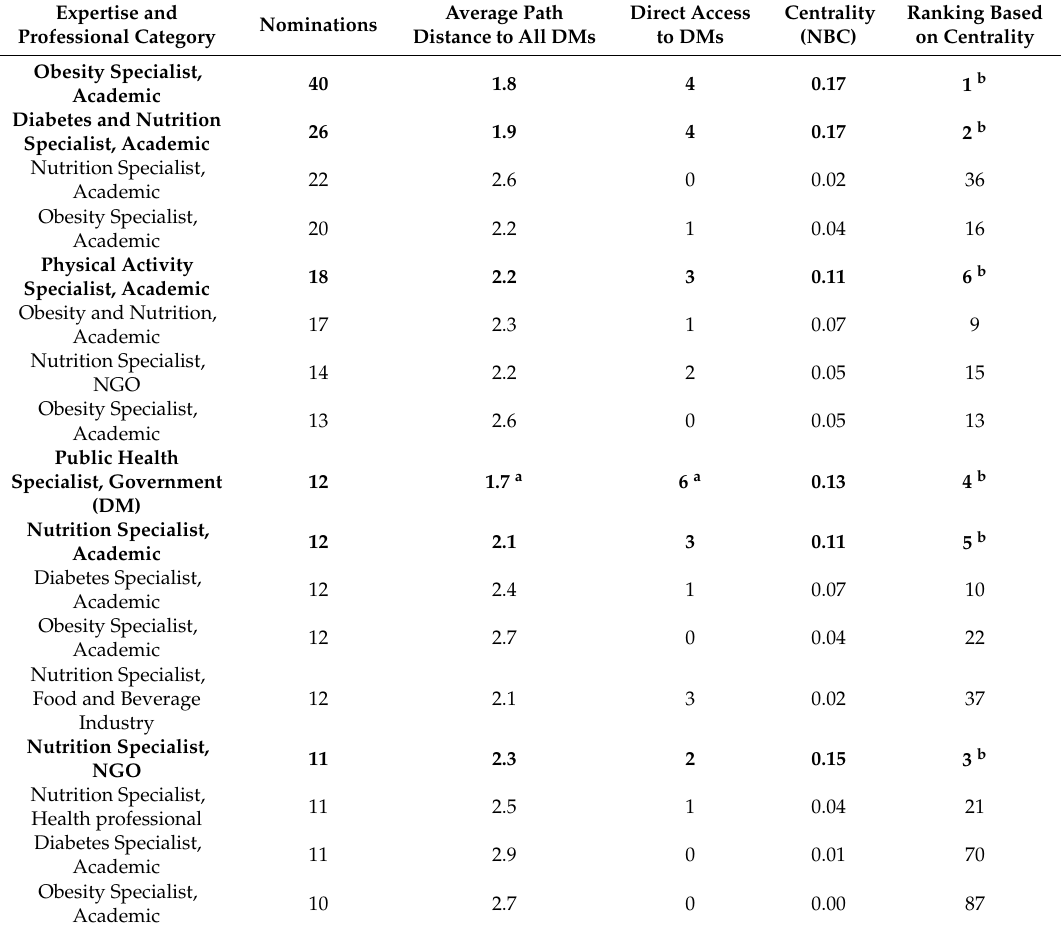
Table 2. Influential people and brokers ranked by number of votes received, presented centrality measured includes average path distance to decision-makers, direct access to decision-makers, and normalised betweenness